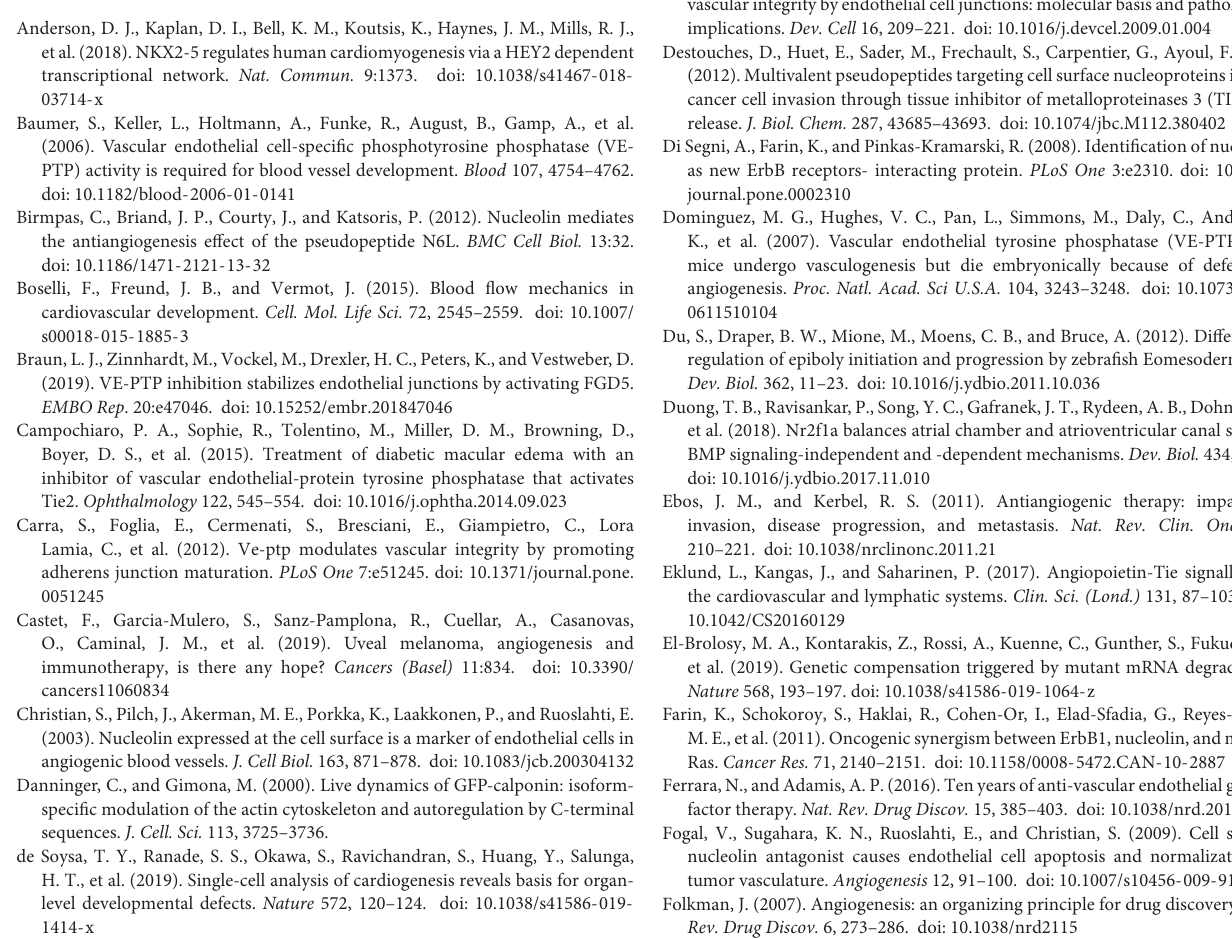
Supplementary Table 5 | Go analysis of the up-regulated genes between nxhl MO and Control MO. Supplementary Table 6 | KEGG pathway analysis. Supplementary Table 7 | All genes involved in KEGG pathway. Supplementary Table 8 | GO enrichment of genes involved in blood vessel morphogenesis and their differential expression value.